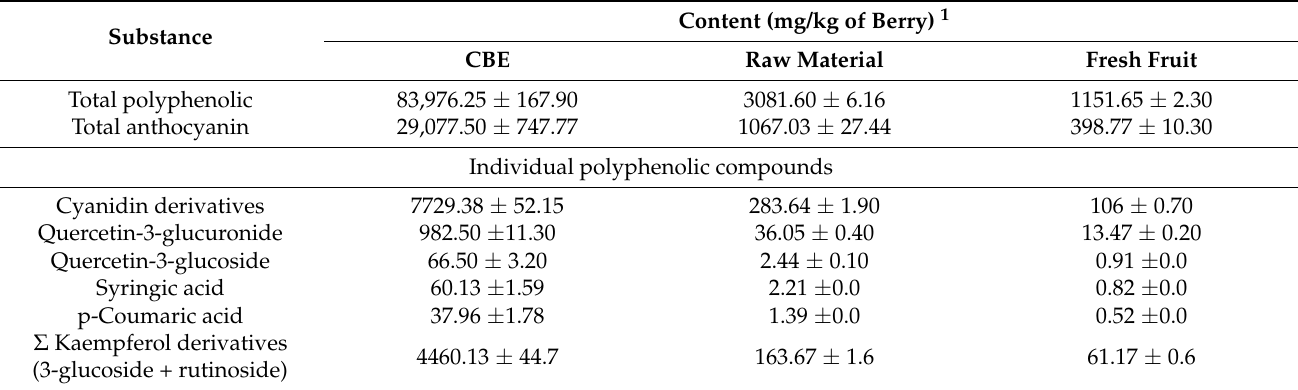
Table 1. Total and individual content (mg/kg) of phenolic compound/subclass identified in Colombian berry ( V.meridionale Sw.) methanolic acid extract (MAE), raw material, and fresh fruit.